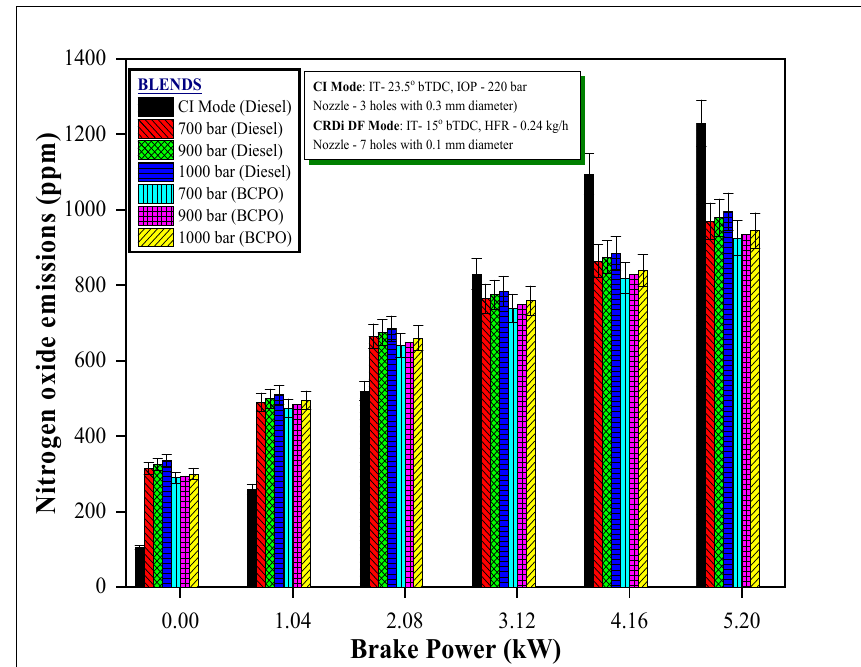
Figure 12. IP and BP influence on CRDi engine NOx